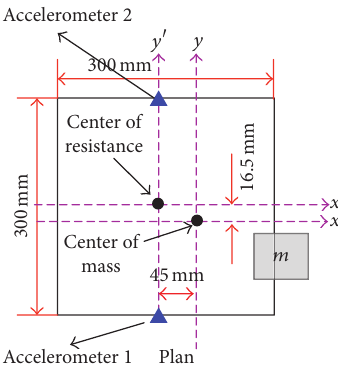
Figure 7: Locations of accelerometers on the top floor of the structure in order to record the relative displacement and rotational responses of the